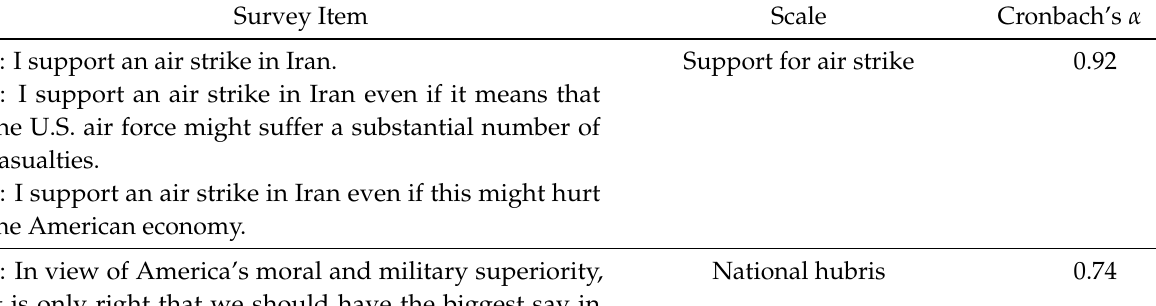
Table 2: Survey Items, Scales, and Internal Consistency Scores Survey